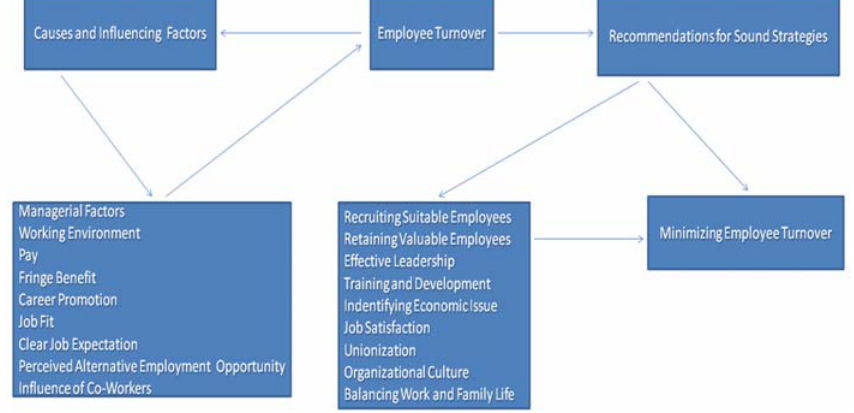
Fig. 1. Conceptual